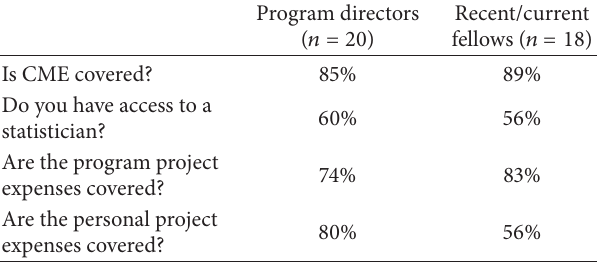
Table 3: Other benefits offered by fellowship